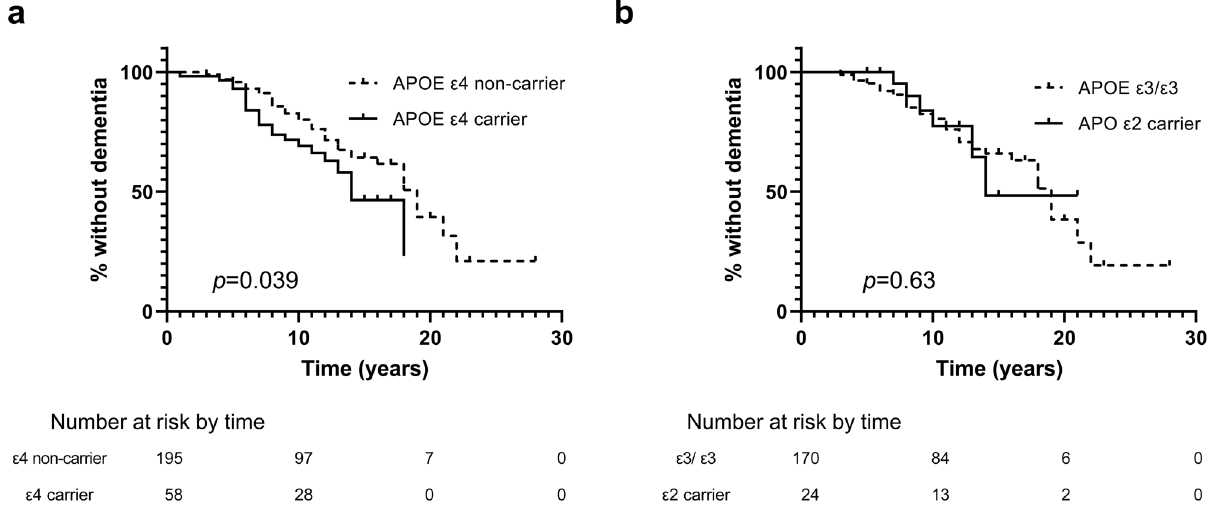
Figure 3. Progression to dementia according to the APOE genotype. ( a ) Kaplan–Meier curves from diagnosis to the onset of dementia between APOE ε4 carriers and non-carriers. ( b ) Kaplan–Meier curves from diagnosis to the onset of dementia between APOE ε2 carriers and ε3/ε3 carriers.